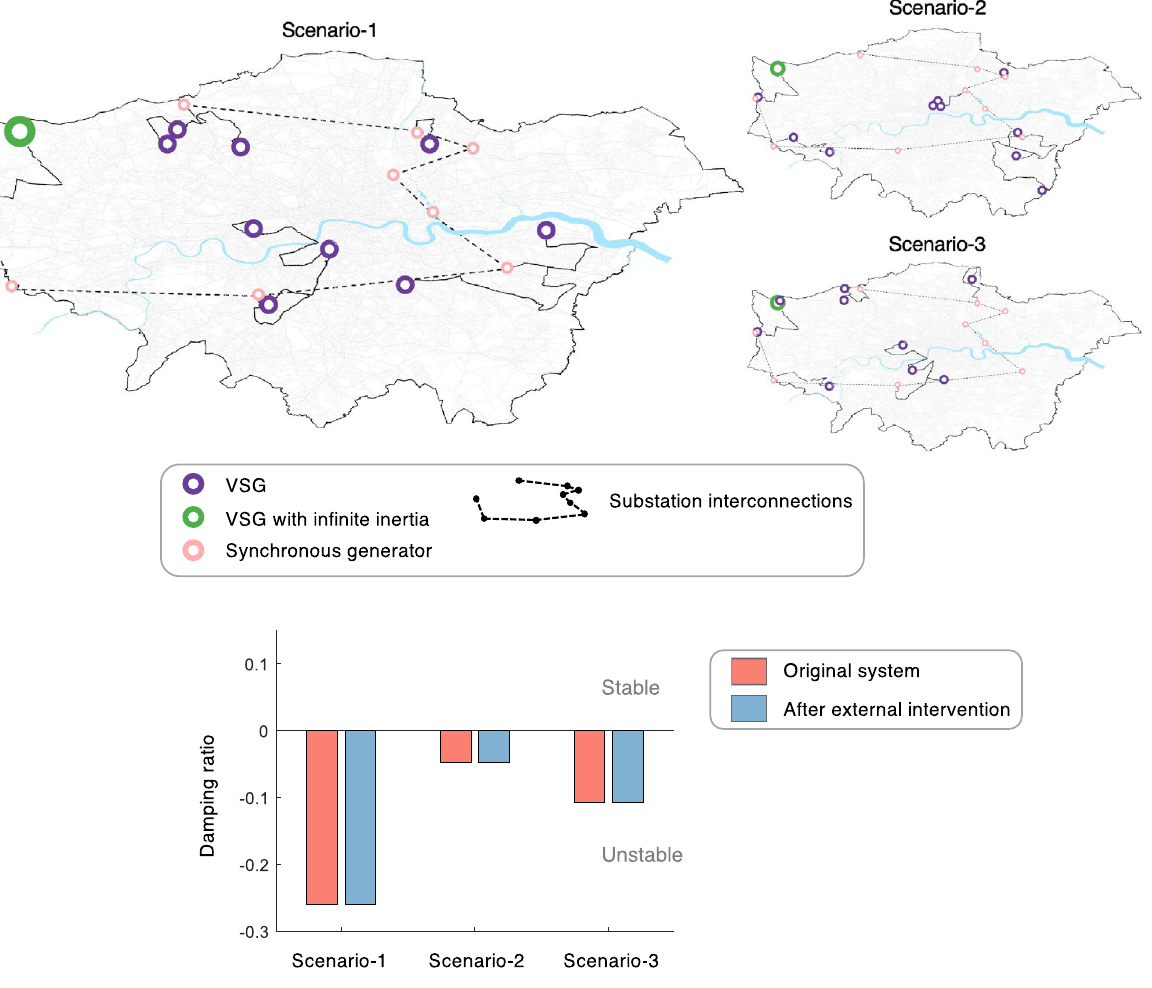
Figure 2. Demonstrating how external interventions may not guarantee stability of the future grid. ( a ) The figure presents three scenarios where 10 VSGs share the load with the existing rotating synchronous generators. In each scenario, a new VSG, marked in green, is added to provide infinite inertia in an exaggerated attempt to stabilize the grid. ( b ) Damping ratios of the scenarios in ( a ) before and after the external intervention, showing no improvement in